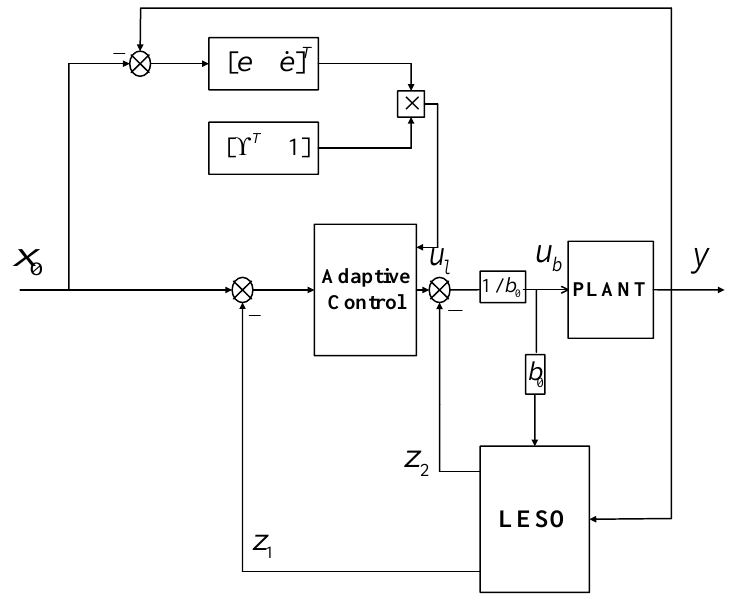
Figure 4. Structure of first-order LADRC controller.